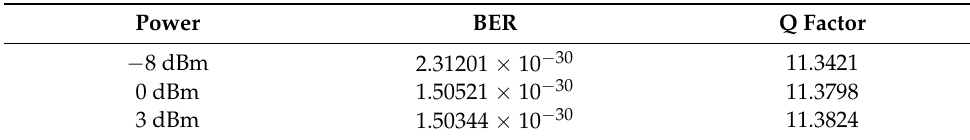
Table 2. CW power versus BER and Q factor with 10 Gbit/s for OAM-DM-WDM-OFDM-PON upstream transmission.